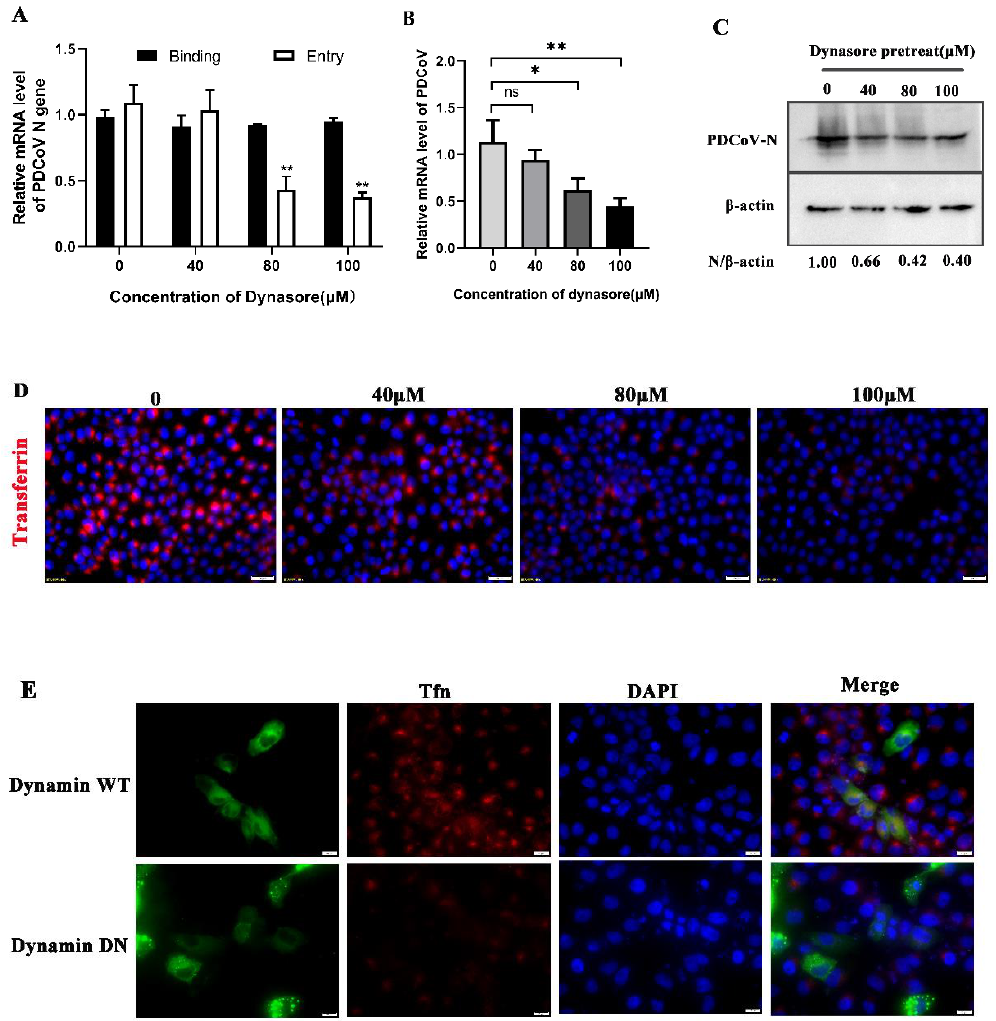
Figure 3. PDCoV entry into PK-15 cells relies on cholesterol. ( A ) PK-15 cells were pretreated with methyl- β -cyclodextrin ( MβCD ) at 37 °C for 1 h and infected with PDCoV (MOI of 5) at 4 °C for 1 h (binding step), and then shifted to 37 °C for 1 h (entry step). Cells were lysed to determine viral mRNA level by RT-qPCR. ( B , C ). Cells were mock-treated or treated with MβCD for 1 h followed by infection with PDCoV (MOI = 0.1). At 24 hpi, mRNA expression levels of total PDCoV were detected by real-time quantitative PCR ( B ) and protein expression levels of intracellular PDCoV were detected by Western blotting ( C ). *** p < 0.001.